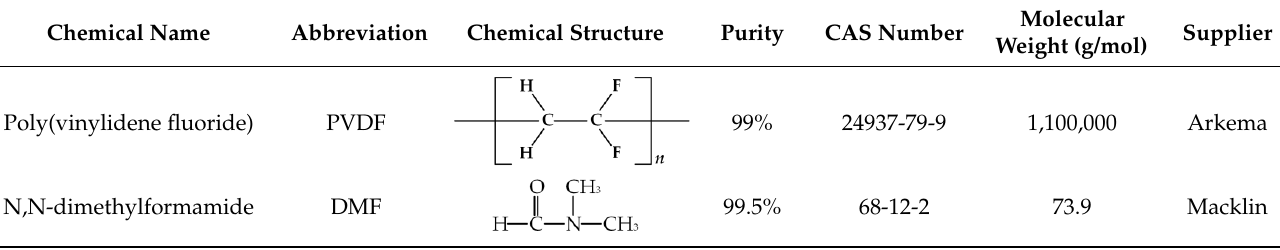
Table 1. Material information of PVDF and DMF.